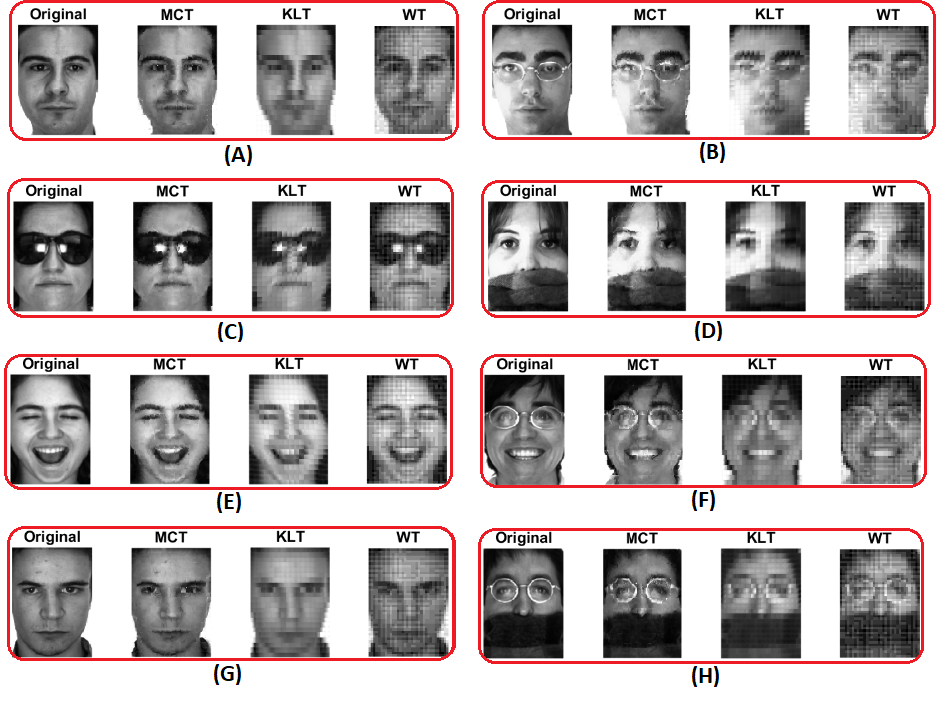
Figure 10. A visual comparative evaluation applied on warp face of AR database: ( A ) neutral expression face during first session, ( B ) wearing prescription eyeglass with right light on during first session, ( C ) wearing sunglasses during second session, ( D ) wearing scarf and right light on during first session, ( E ) scream during second session, ( F ) smile face wearing prescription eyeglassduring second session, ( G ) anger face during first session, ( H ) anger face wearing scarf and prescription eyeglasses during second